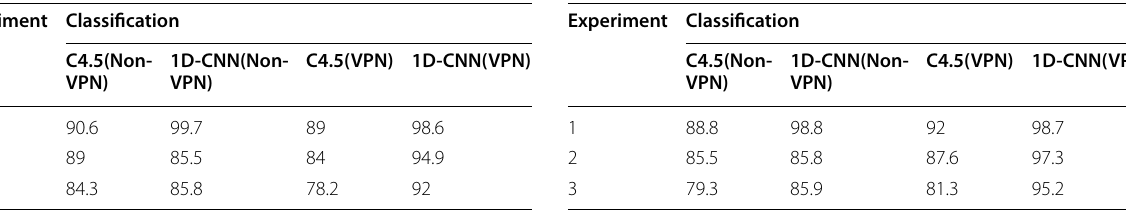
Table 6 Comparison of recall of encrypted and non-encrypted traffic identification for C4.5 and